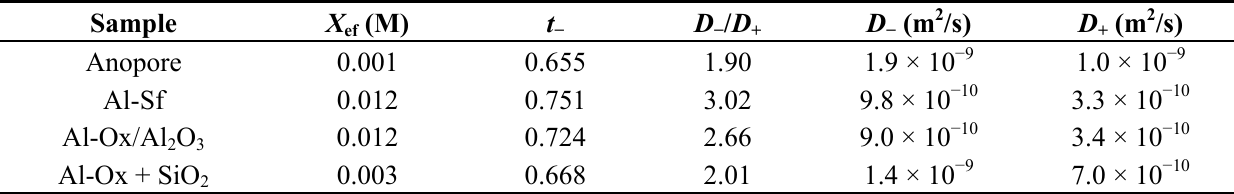
/ D ) and ions diffusion coefficient values ( D − +